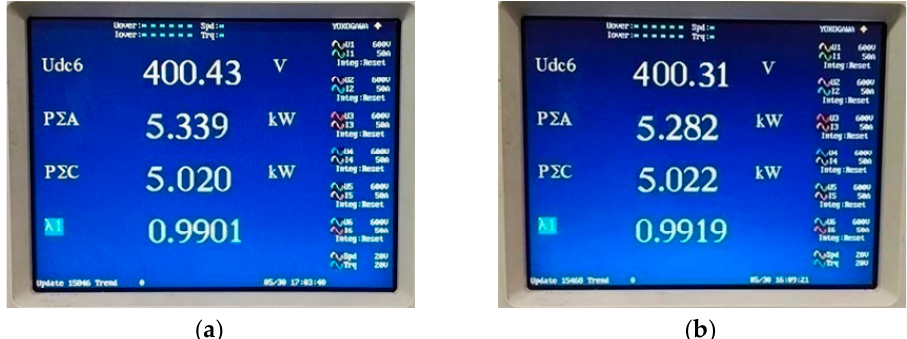
Figure 13. Fourier analysis and comparison of current i a of the two NPV control strategies in the experiment. ( a ) ZSV-J; ( b ) the proposed NPV control strategy.